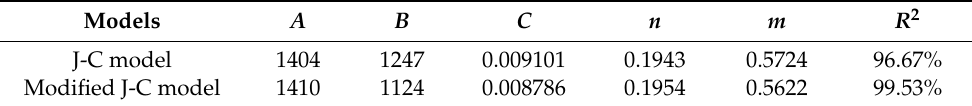
Table 4. Fitted parameter values.